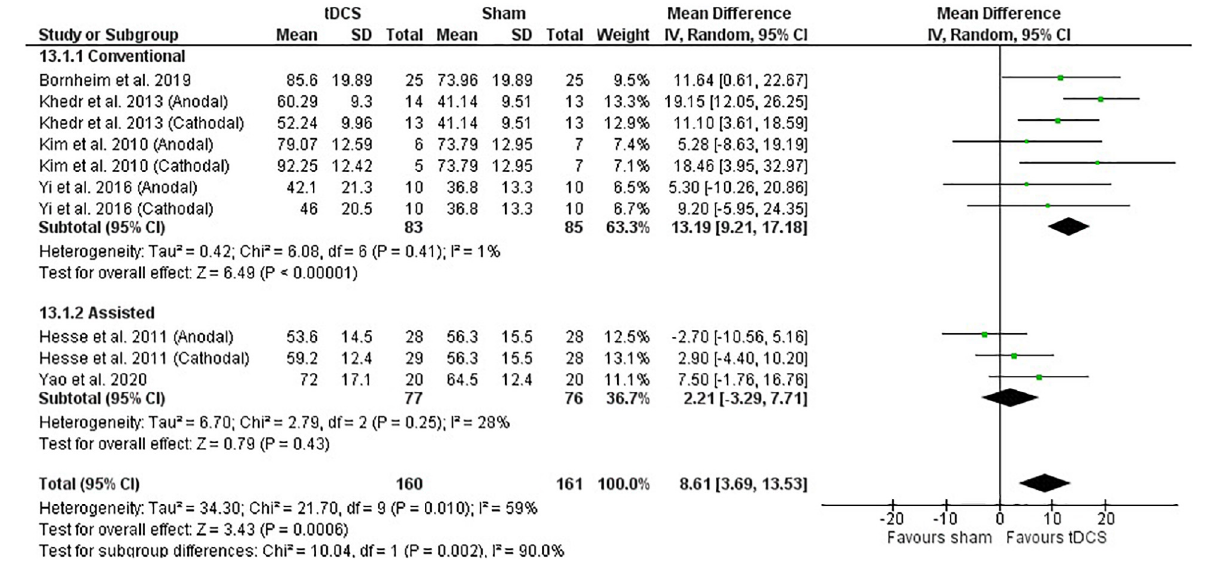
MCID in the sham group shows the effectiveness of the associated therapy. tDCS benefits, estimated with group differences in effect sizes, were observed, despite the associated therapy. Our results agree with others (Elsner et al., 2020; Van Hoornweder et al., 2021) showing limited, but positive evidence of effect of tDCS on upper limb motor function (i.e., the FMA) and gross motor recovery (i.e., the BI). For muscle tone and the lower extremity function, the evidence is